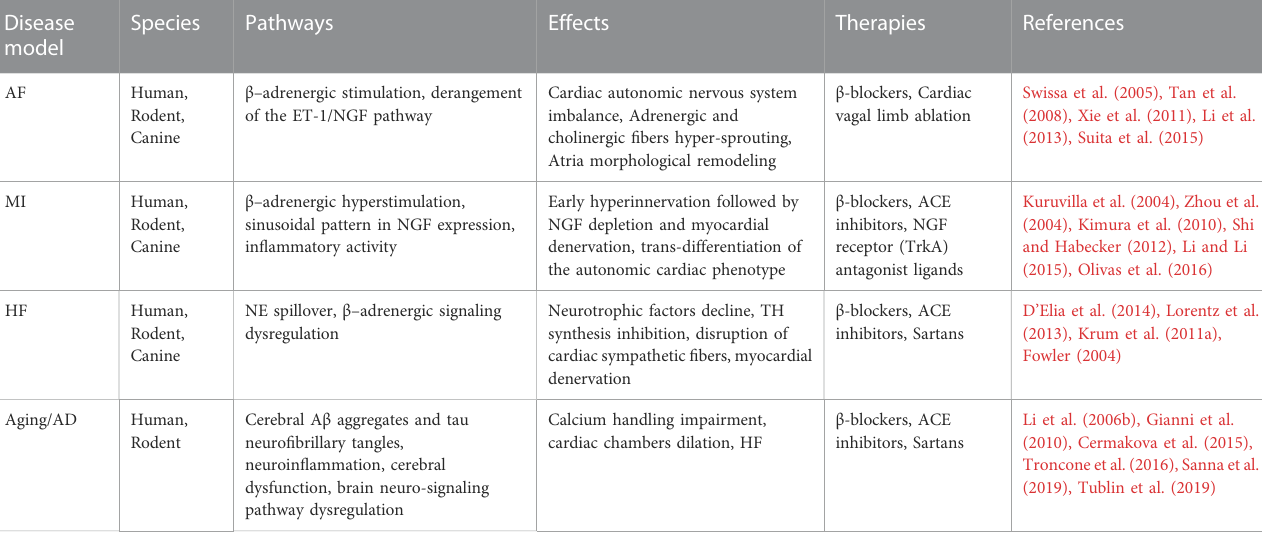
TABLE 1 Neurochemical control of cardiovascular